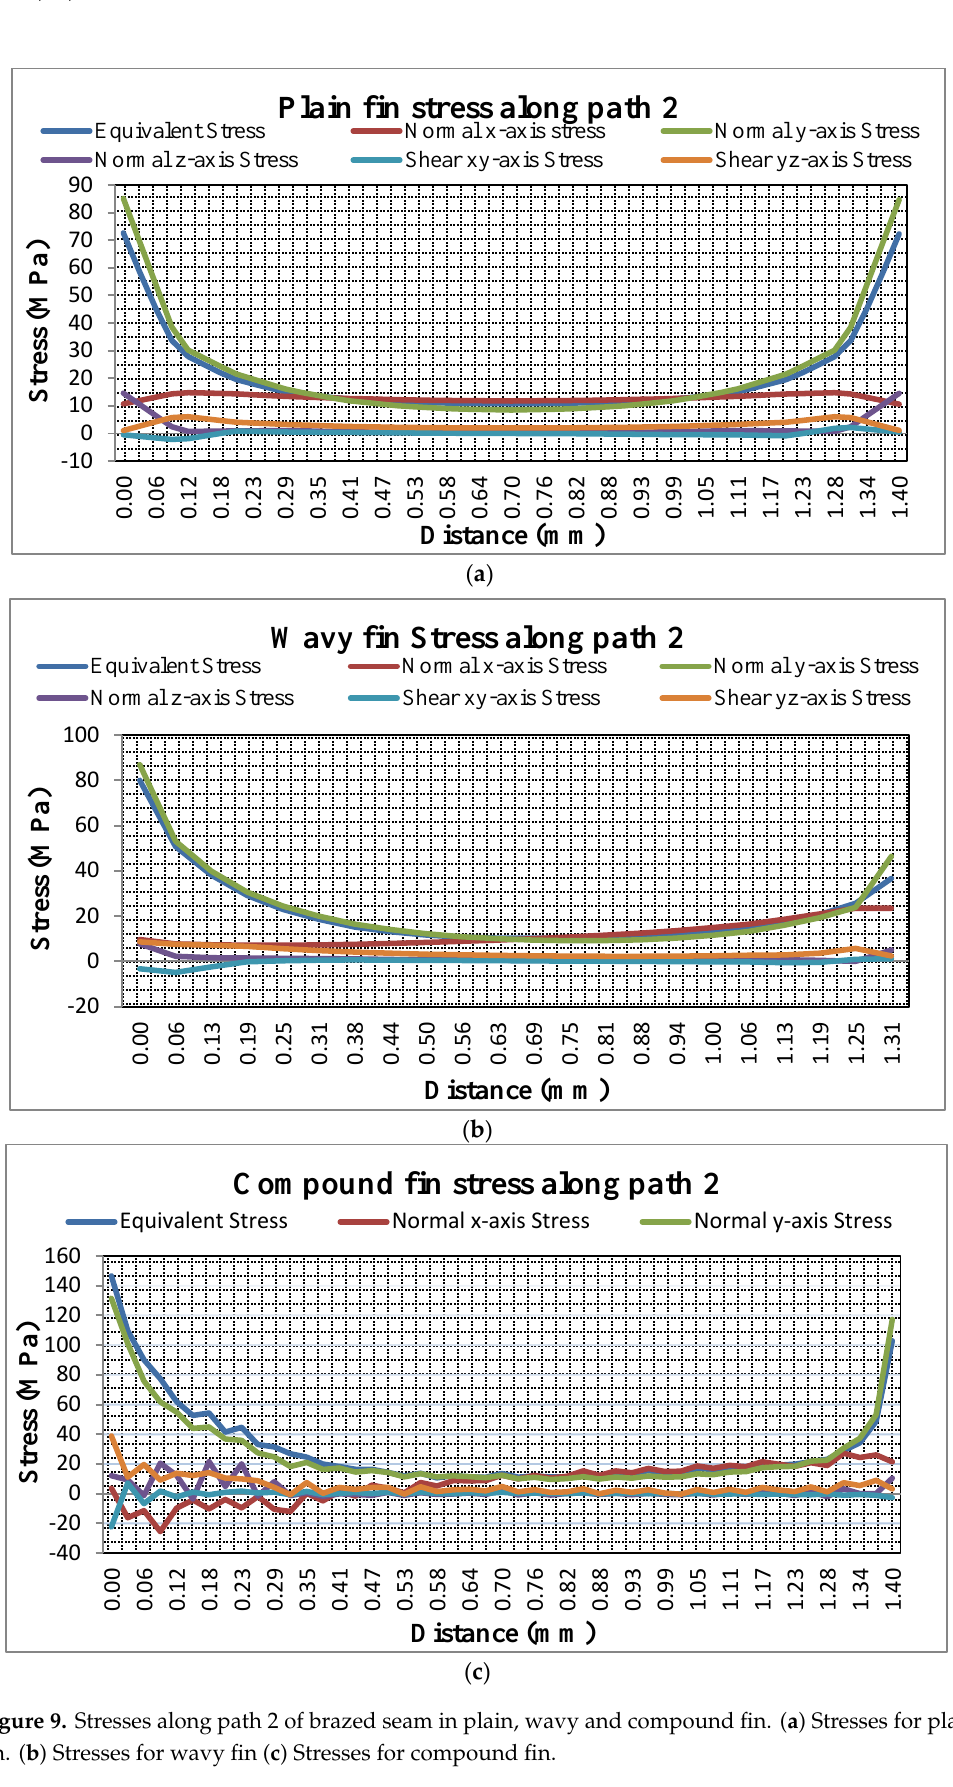
Figure 9. Stresses along path 2 of brazed seam in plain, wavy and compound fin. ( a ) Stresses for plain fin. ( b ) Stresses for wavy fin ( c ) Stresses for compound fin. Table 4. Factor of safety along path 2 for plain, wavy and compound configuration.